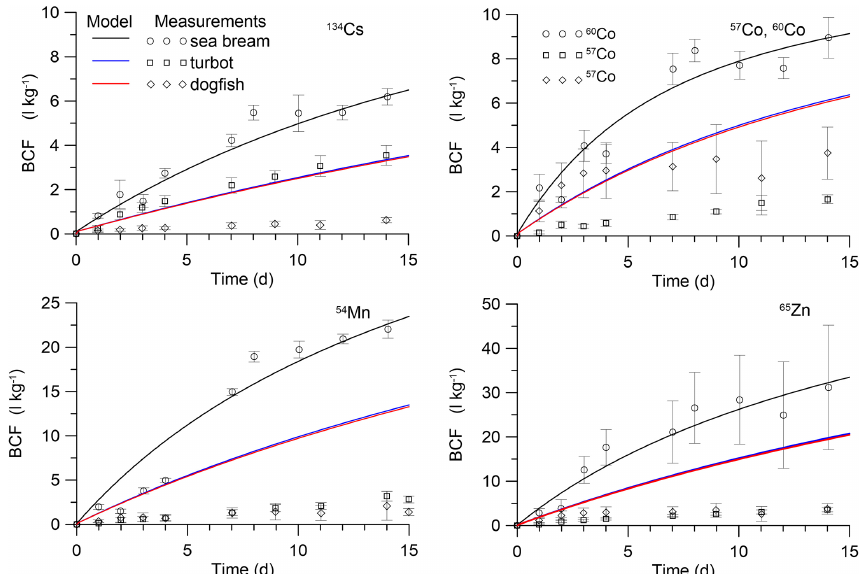
Figure 5. Simulated BCF in marine fish during the period of exposition in water. The simulations are compared with isotope measurements by Mathews et al. (2008) in juvenile sea bream ( Sparus auratus ) and measurements by Jeffree et al. (2006) in turbot ( Psetta maxima ) and spotted dogfish ( Scyliorhinus canicula